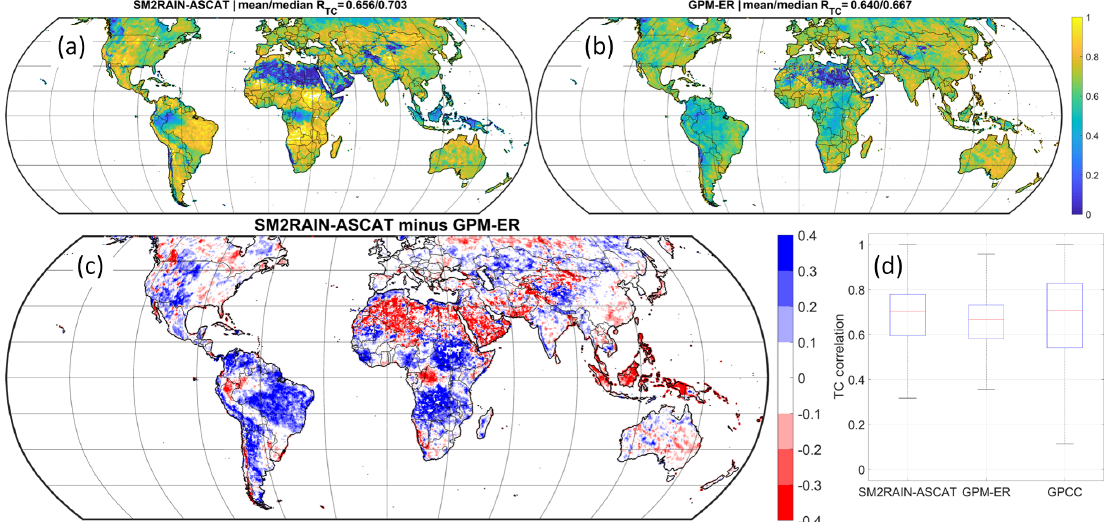
Figure 7. Global triple-collocation, TC, results. (a) R TC map for SM2RAIN–ASCAT, (b) R TC map for GPM-ER, (c) differences between (a) and (b) , i.e. blue pixels for areas in which SM2RAIN–ASCAT (GPM-ER) is performing better and red for those in which it is performing worse, and (d) box plot of R TC for SM2RAIN–ASCAT, GPM-ER, and GPCC. SM2RAIN–ASCAT is performing significantly better than GPM-ER in South America and Africa (excluding desert and tropical-forest areas), elsewhere the two satellite products perform similarly.